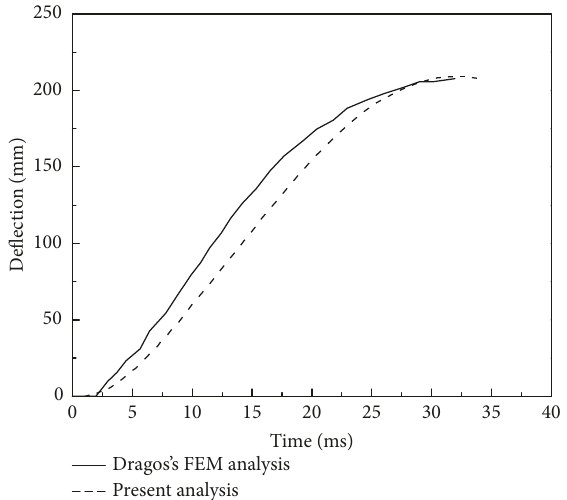
Figure 7: Comparison of the midspan displacements for blast no.1.